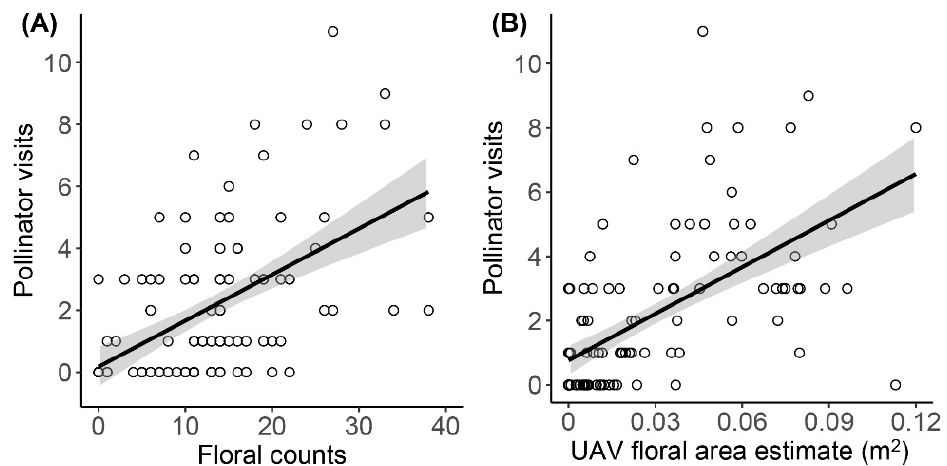
Figure 3. Visual estimates of pollinator activity in 0.25 m 2 quadrats in relation to ( A ) visual counts of flowers within quadrats, and ( B ) UAV-estimated floral area within the quadrats. For ease of interpretation, lines represent the linear relationship between untransformed floral counts, with shaded areas indicating 95% confidence intervals (see Table 2).